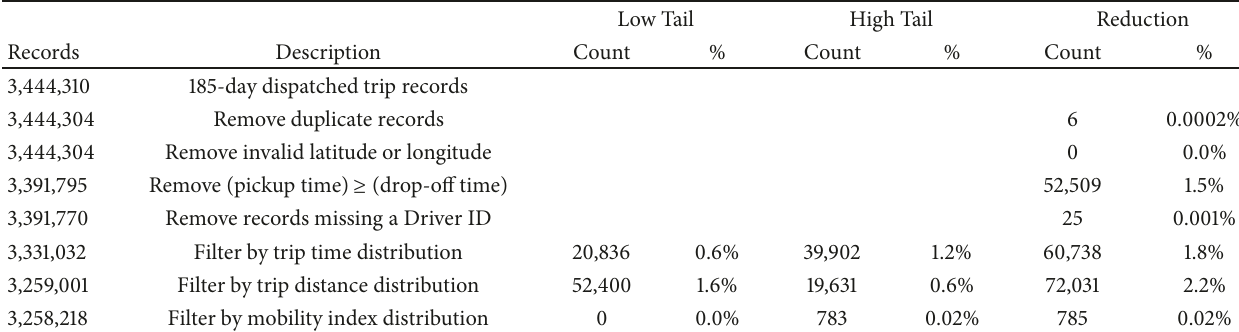
Table 1: Summary of data reduction and